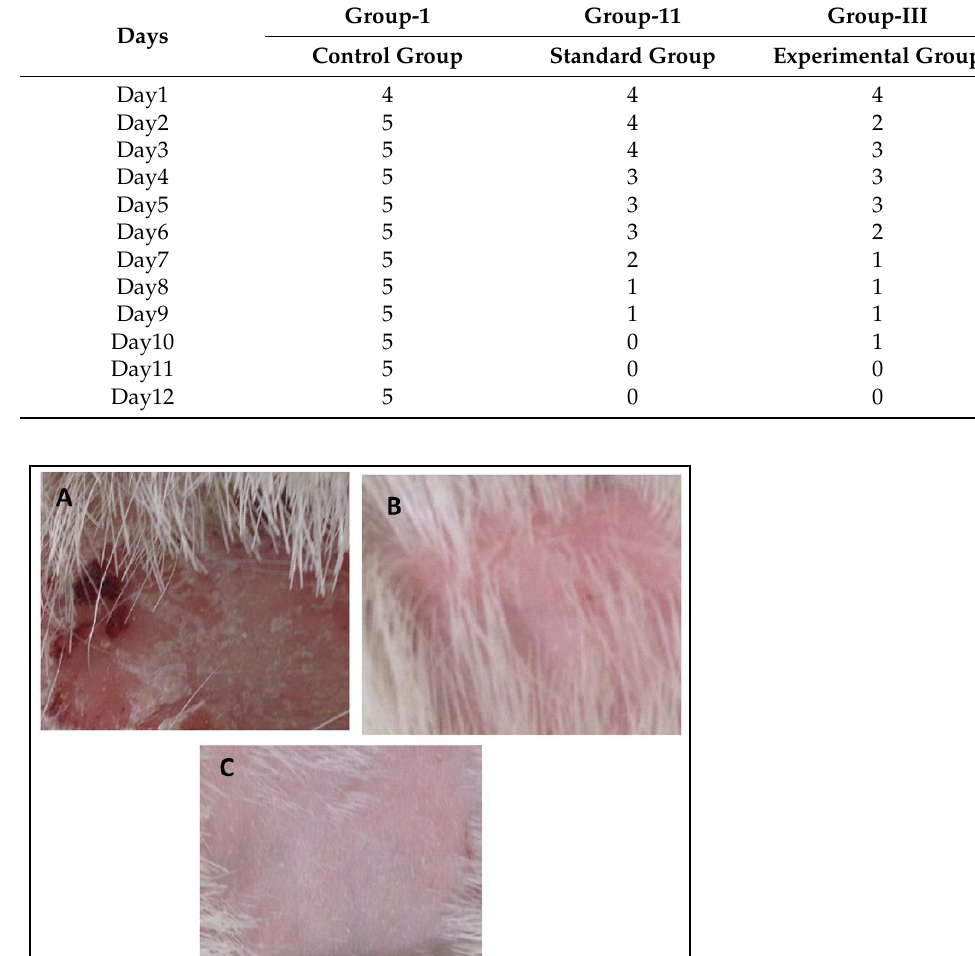
Table 8. Relative scoring after treatment of rabbits for 12 days.